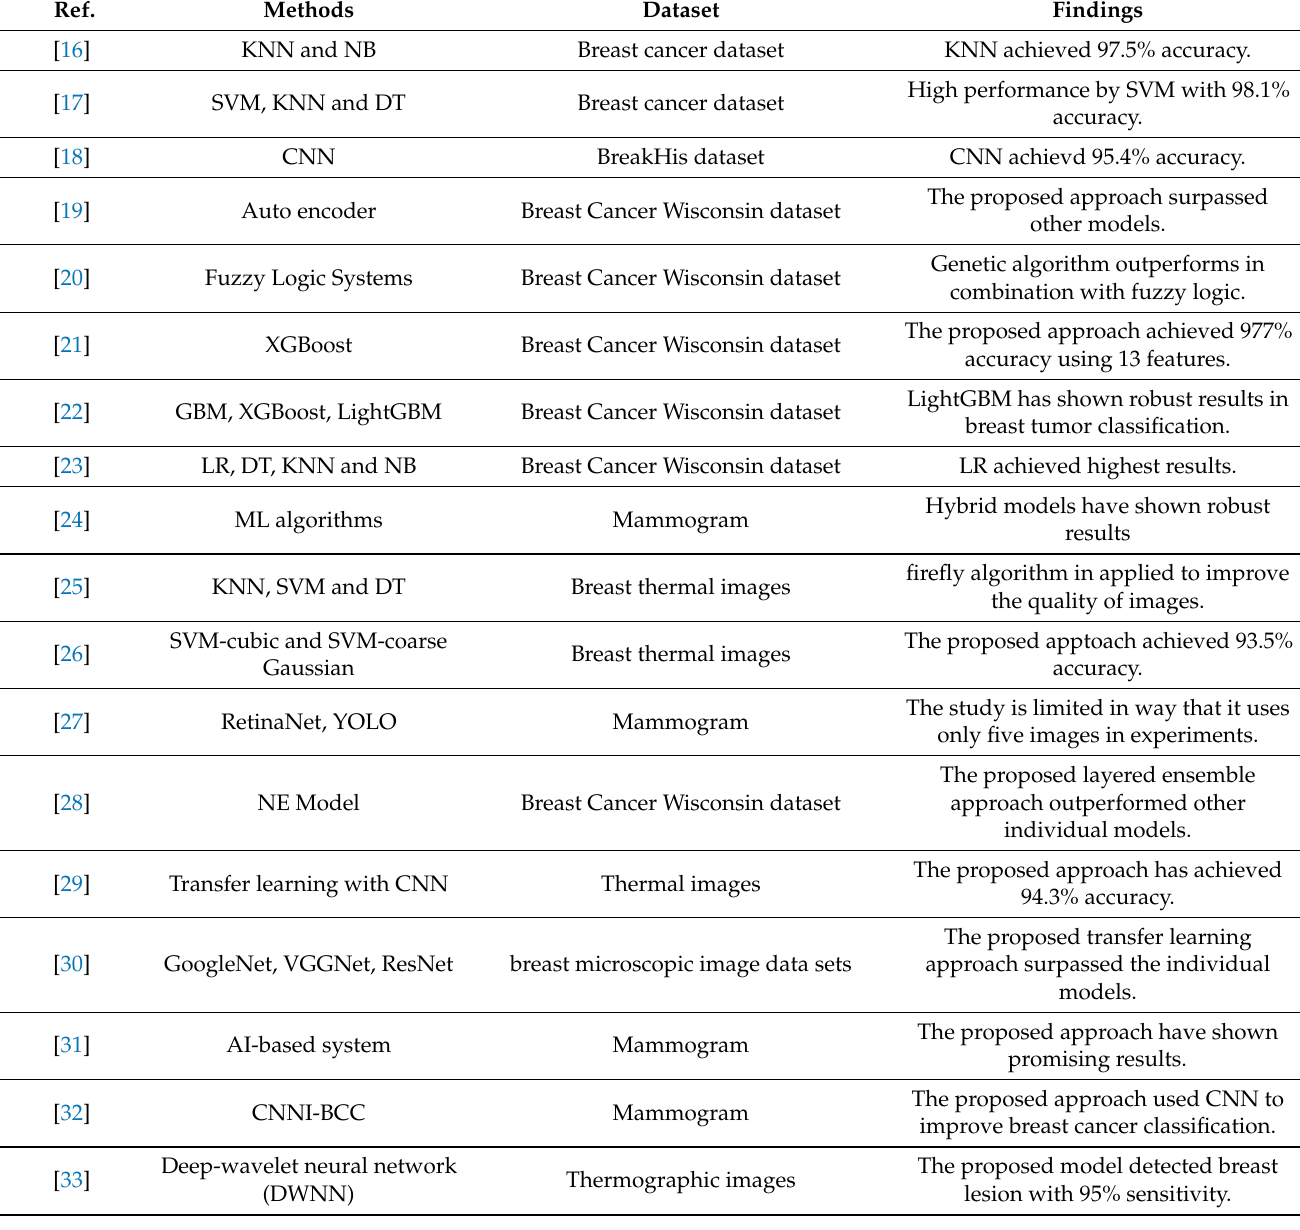
Table 1. Comparative analysis of the existing